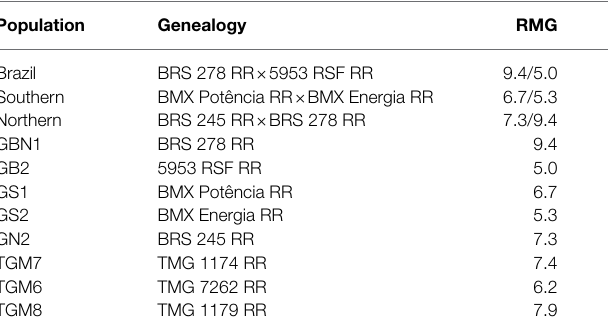
TABLE 1 | Genealogy and relative maturity group (RMG) of 11 soybean populations used in